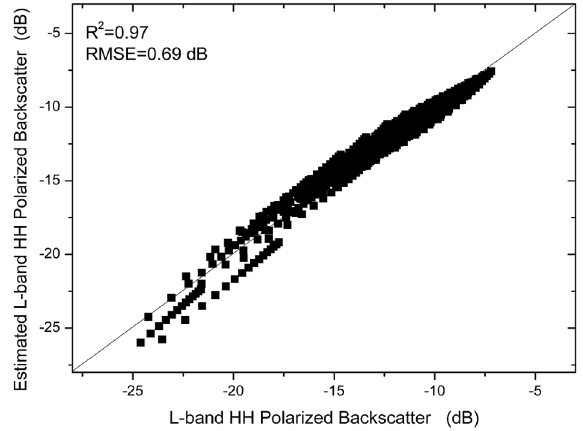
Figure 9. Comparisons between L-band HH polarized backscatter and its estimation derived from P-band VV polarized backscatter based on the AIEM